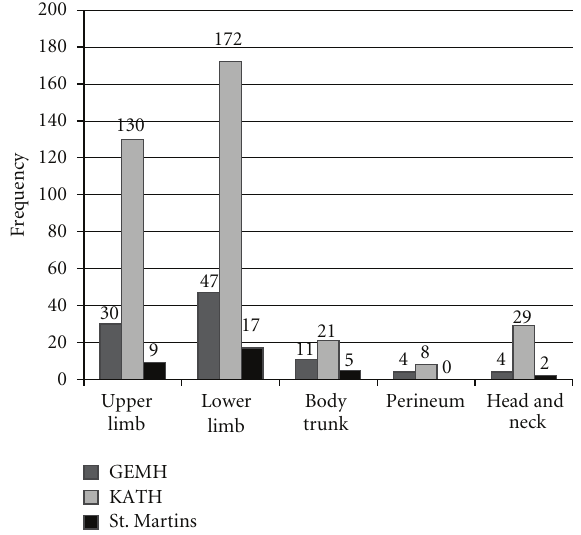
Figure 2: Location of the Buruli ulcer disease in the patients at the various treatment centers.